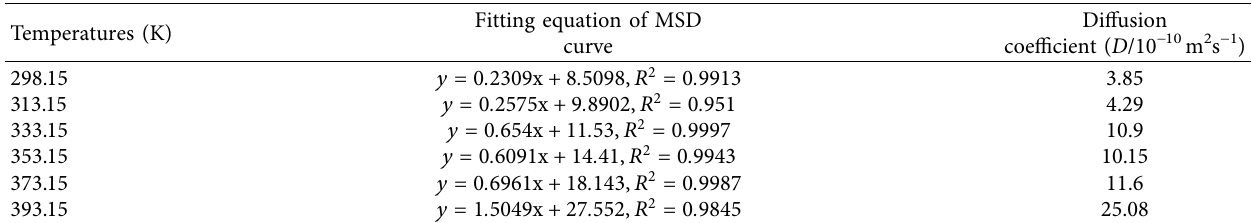
2 -asphalt model at diferent temperatures.